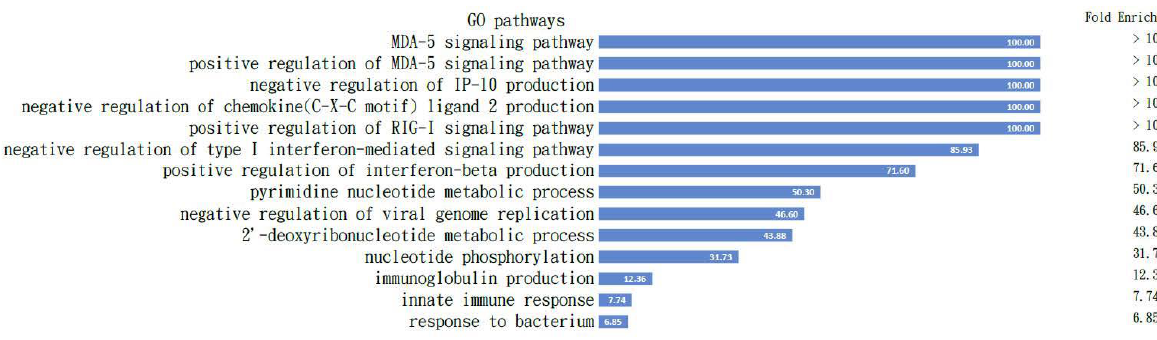
Figure 5. Pathways activated in B cells. All the proteins listed in Table 1 are comparable to the Mus musculus in the Panther classification pathway analysis and the results demonstrated positive regulation of the MDA5 signaling pathway with highest fold enrichment over 100; the pathways activated with these proteins are demonstrated. The fold changes are listed in the column on the right.